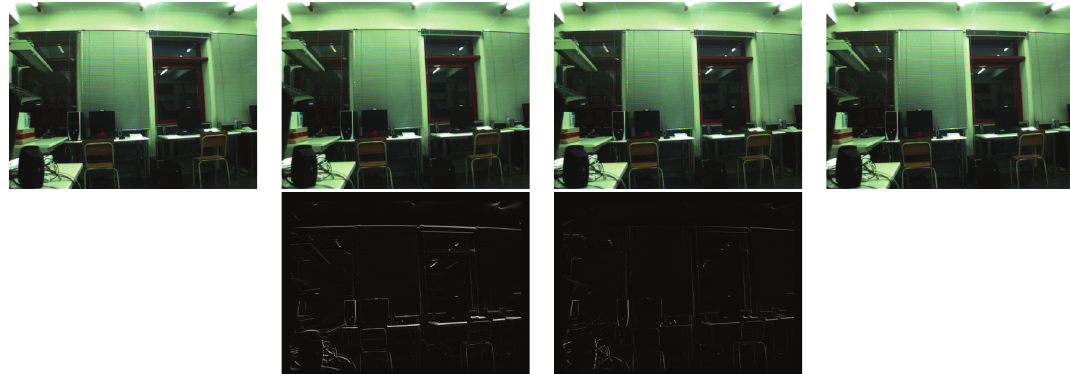
Figure 6: Two consecutive frames, the right column are the unstabilized while the compensated ones are depicted at the left one.